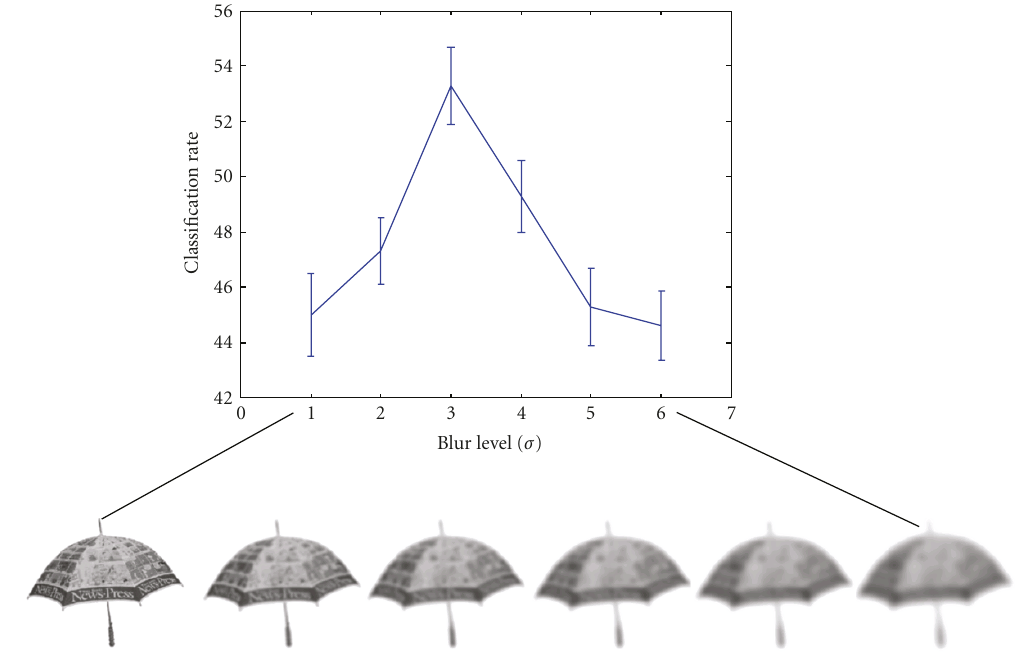
Figure 14: Evaluation of blurring level in terms of categorization rate.